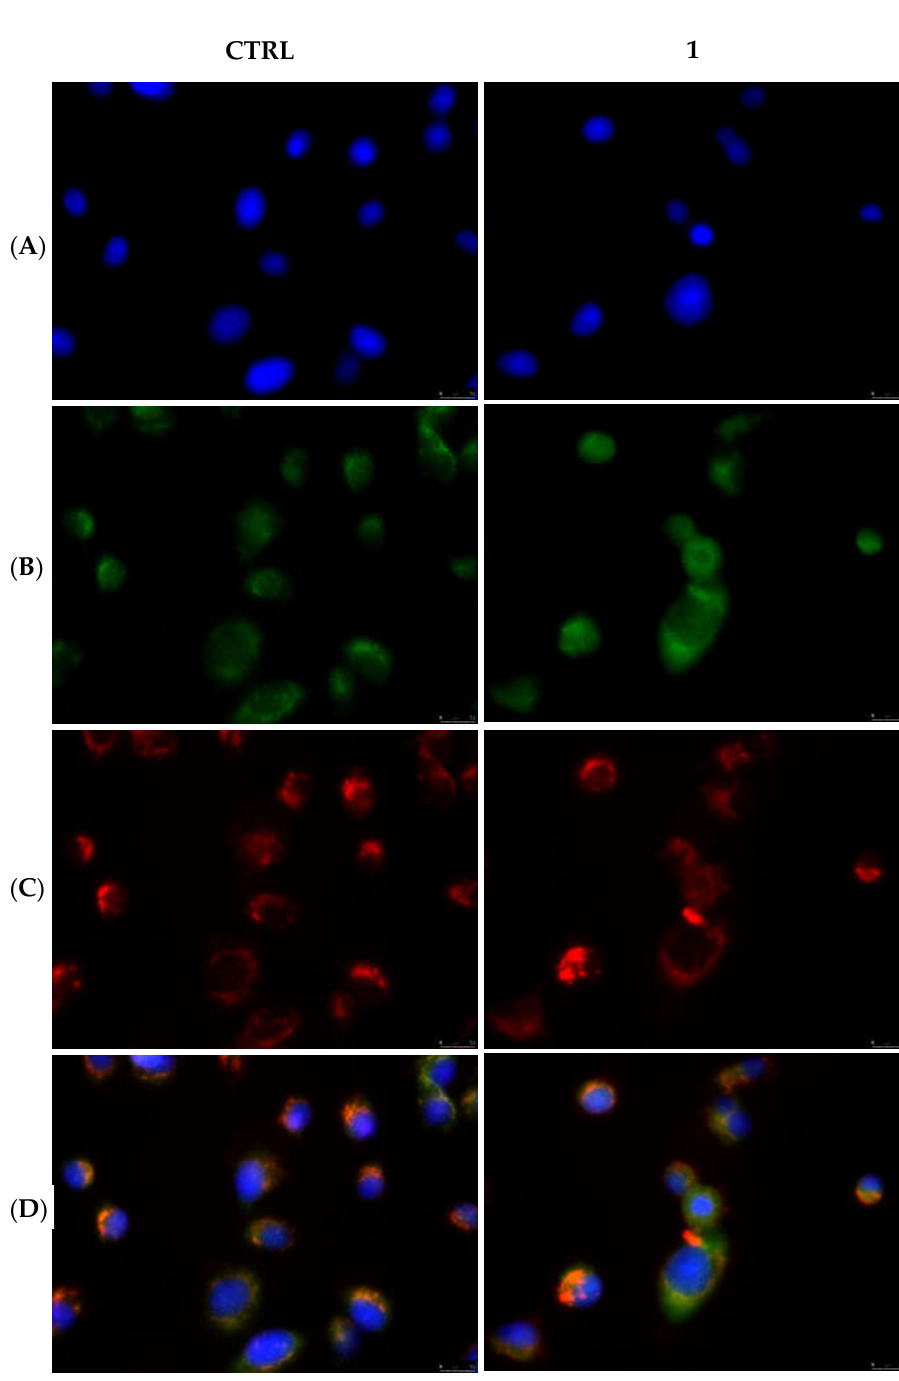
Figure 11. Mitochondria staining and cytochrome c detection in MDA-MB-231 cells. In the CTRL cells as well as in the cells treated with compound 1 at its IC50 value for 24 h, cytochrome c is localized within mitochondria. Panels ( A ), DAPI λ ex/em = 350/460 nm; Panels ( B ), Alexa Fluor CF 488 λ ex/em = 490/515 nm; Panels ( C ), MitoTracker Deep Red FM probe λ ex/em = 644/665 nm; Panels ( D ), overlay channels. Images were acquired at 40× magnification and representative fields are shown.